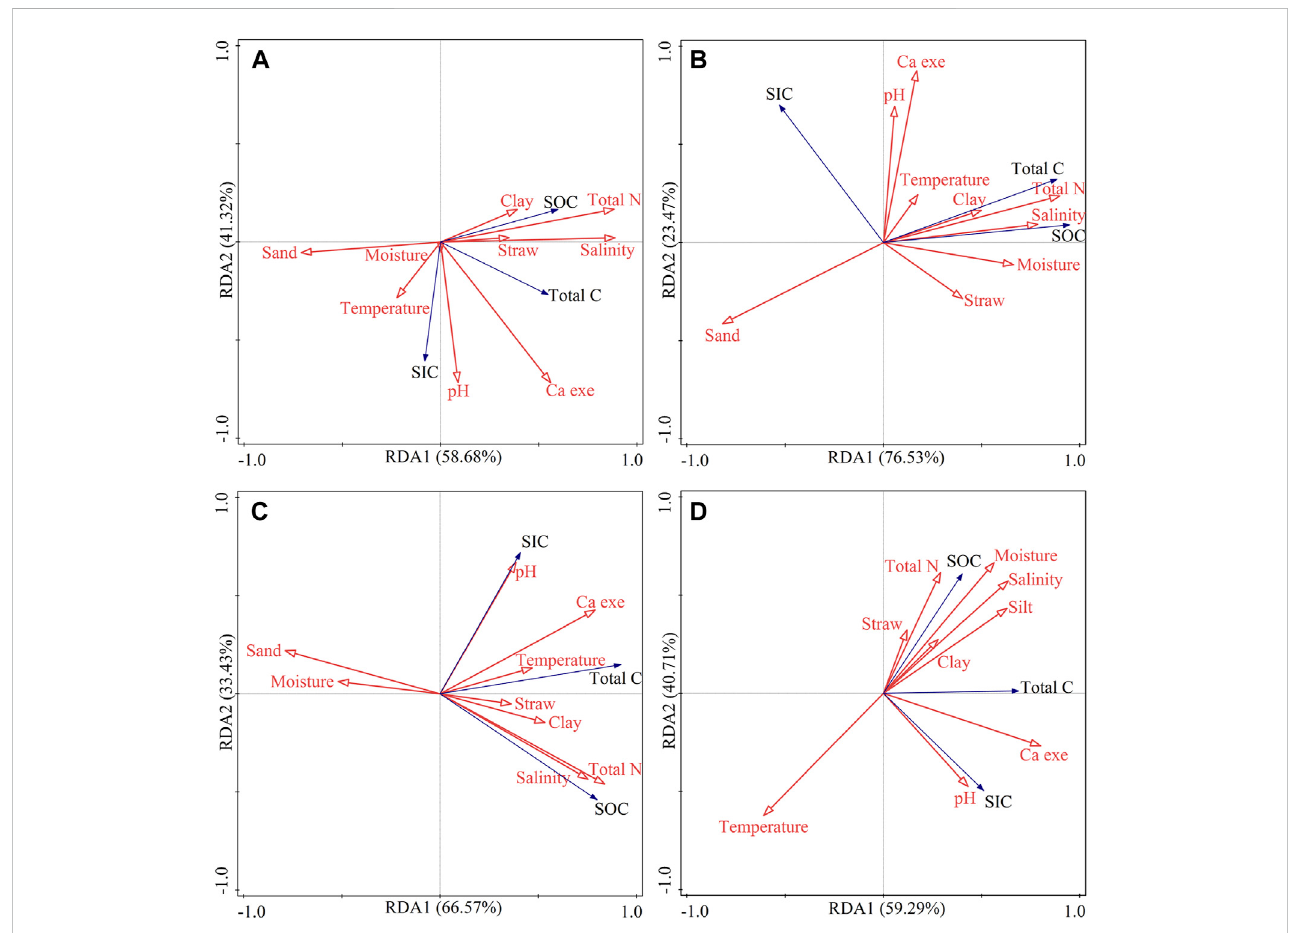
FIGURE 4 Redundancyanalysis(RDA)resultsoftheeffectsofenvironmentalfactors onSOCandSICstockintheentiresoilpro fi le(0 – 100 cm) (A) ,surfacelayer (B) , subsoil layer (C) , and under-subsoil layer (D)